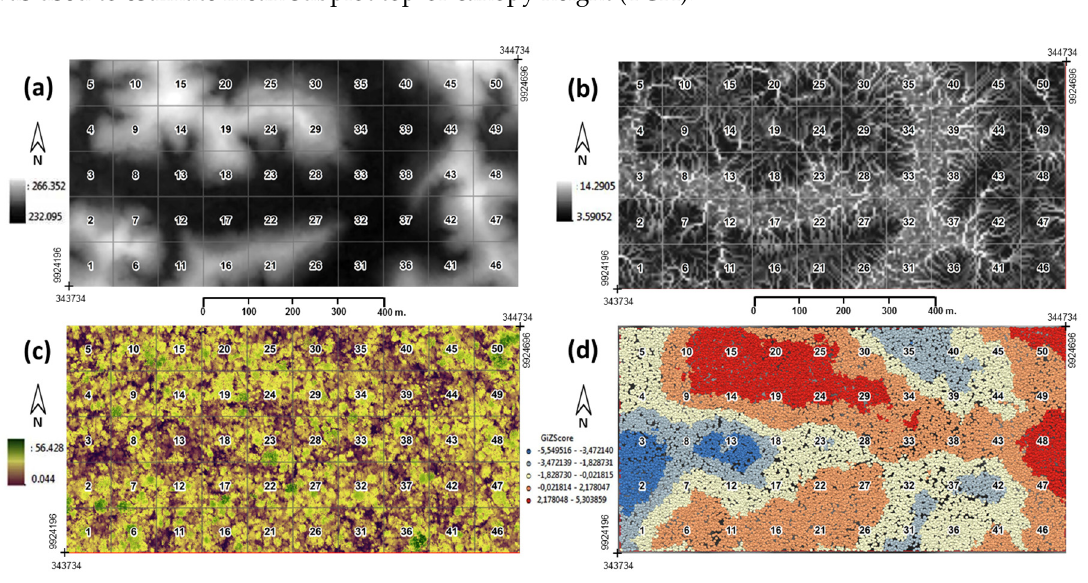
Figure 2. Variables used to select subplots for fitting and validating the general model. ( a ) Digital Terrain Model at 5 m spatial resolution; ( b ) Compound Topographic Index at 5 m spatial resolution; ( c ) Canopy Height Model at 0.5 m spatial resolution; and ( d ) Hot Spot Analysis of ACD distribution.